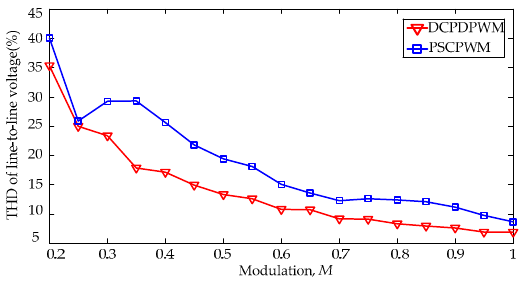
Figure 7. THD of line-to-line voltage for DCPDPWM and PSCPWM methods in different modulation index with circulating current harmonics cancellation scheme.